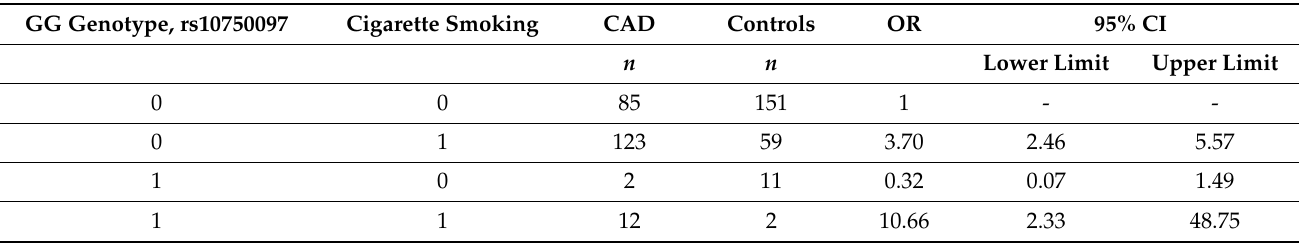
Table 4. Interaction analysis between GG homozygosity of the rs10750097 polymorphism and cigarette smoking.